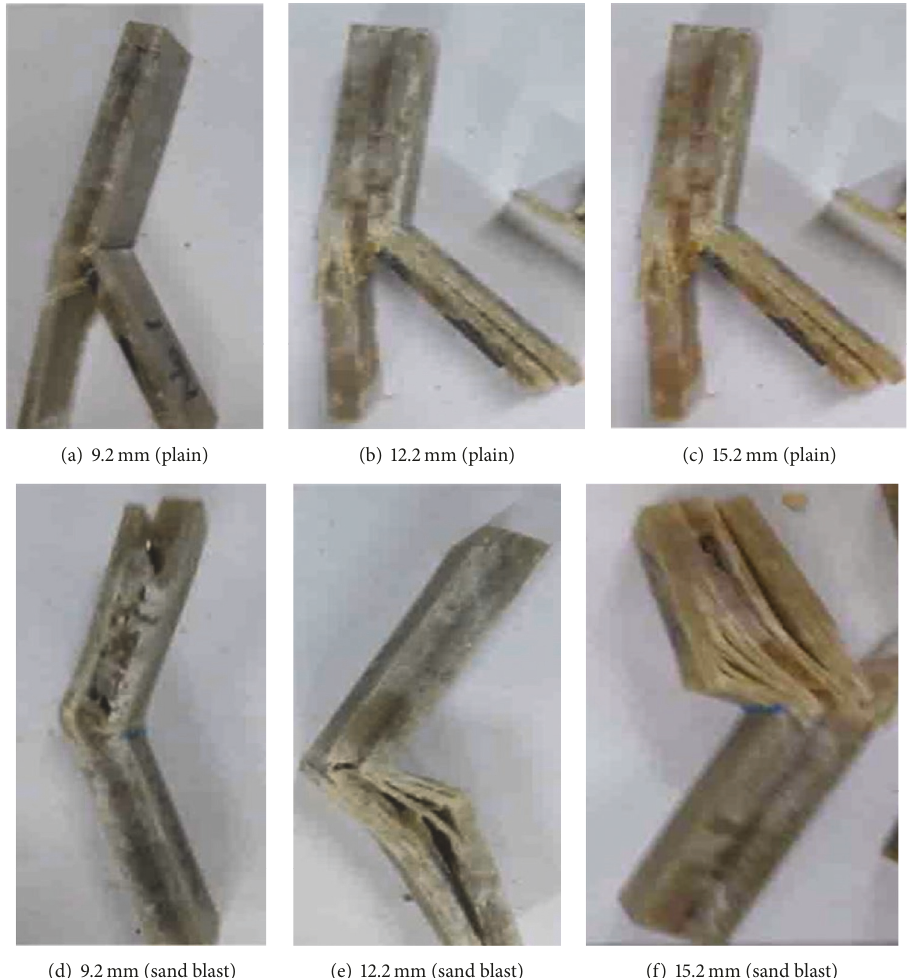
Figure 17: Fracture deformation with thickness of hybrid panels after MgSO 4 solution